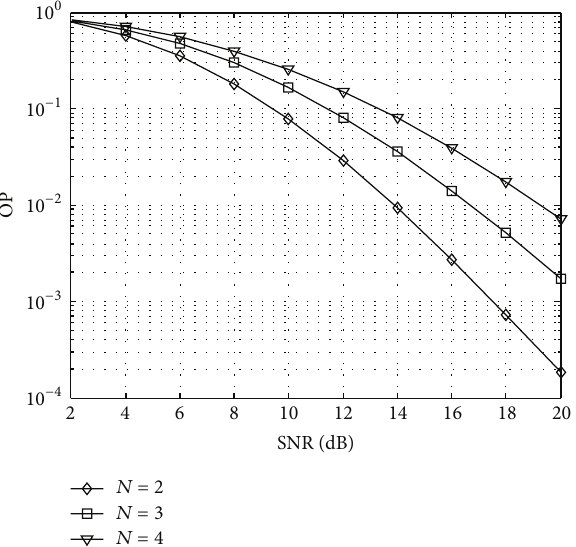
Figure 5: The effect of the number of cascaded components 𝑁 on the OP